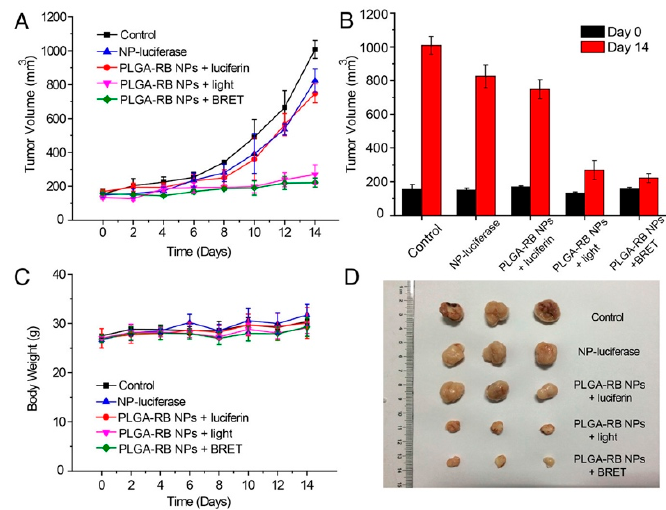
Figure 13. In vivo demonstration of BRET-mediated photodynamic therapy (PDT) using PLGA nanoparticles loaded with rose bengal (RB) and FLuc. ( A ) Tumor growth over time when treated with the PLGA NPs. Only the pink and green traces show data from animals dosed with all the elements necessary for PDT. The pink group was exposed to external excitation light as a more traditional approach to PDT, while BRET-mediated local excitation of the construct was used for PDT in the green group. ( B ) Tumor volume on day 0 and day 14 after PDT treatment. ( C ) Body weight change after intratumoral injections of the NPs showed no significant change, suggesting low toxicity of the PDT treatment. ( D ) Excised tumors from the five treated groups on day 14. Reprinted with permission from [157]. Copyright 2018, American Chemical Society.